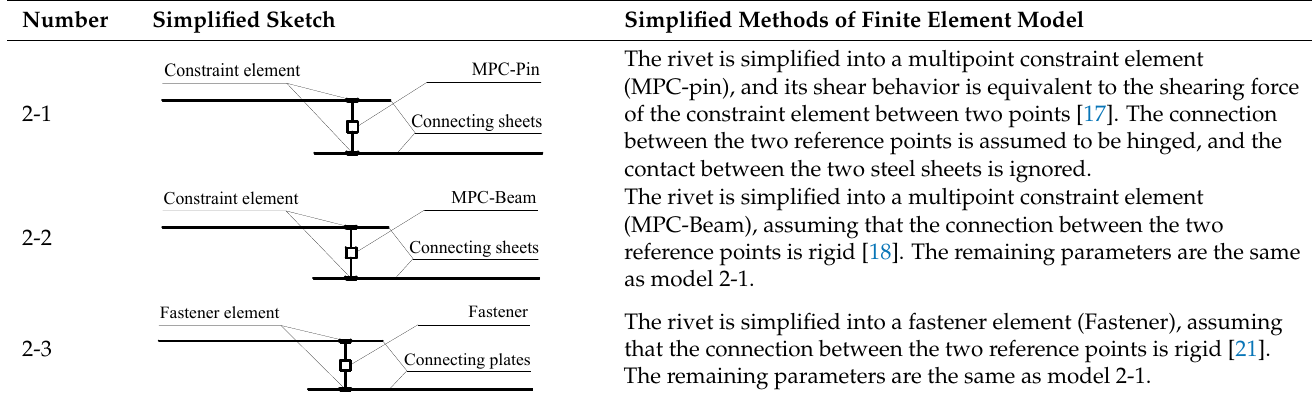
Table 7. The third simplified methods of the finite element model for the SPR